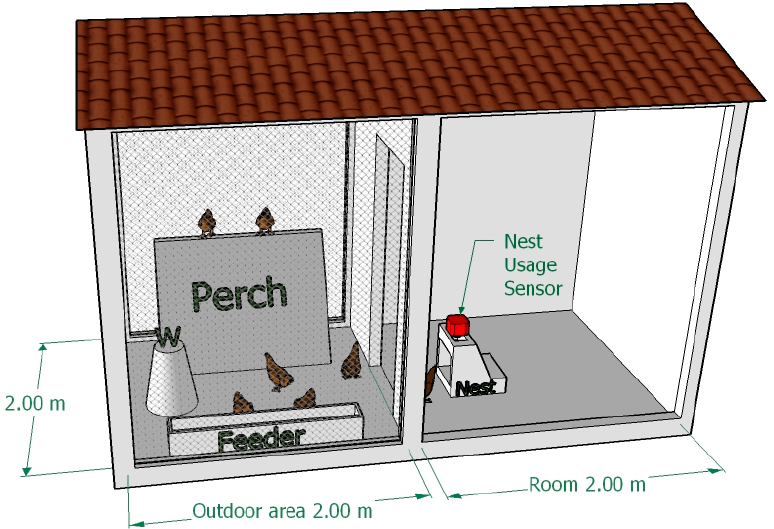
Figure 1. Dimensions and of the experimental housing system set-up. The positioning of the experimental nesting box and of some main components, is reported. The water dispenser is represented by the symbol “W”.